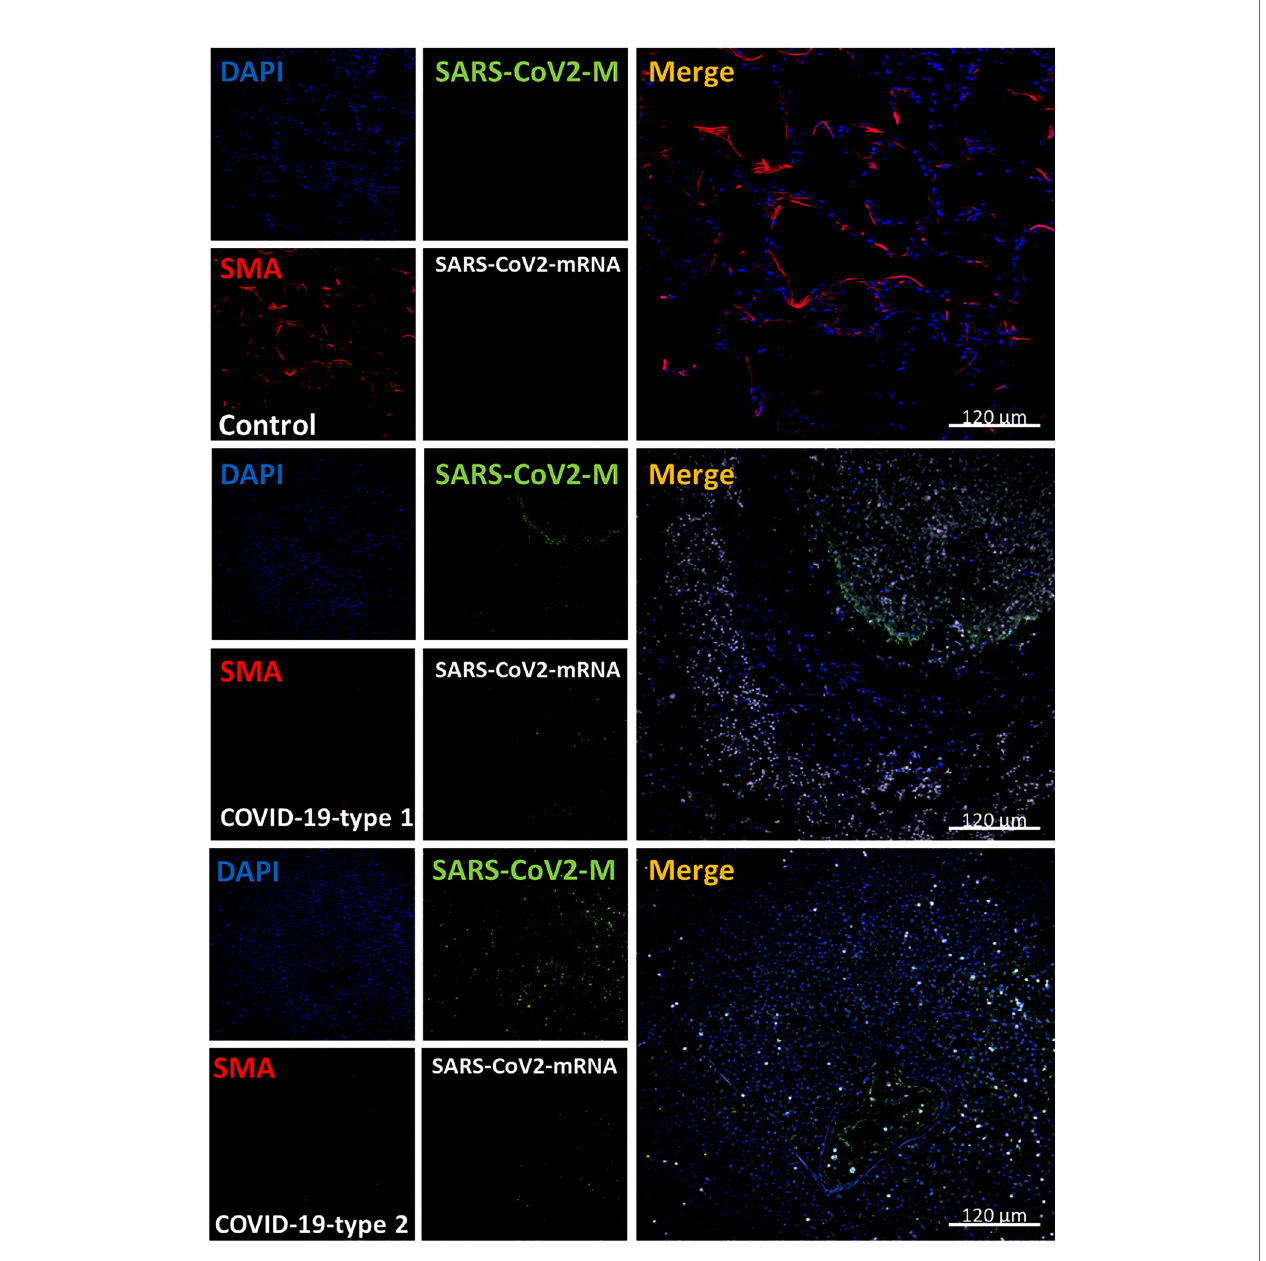
FIGURE 8 | COVID-19 disease induces the total loss of smooth muscle actin cells and lung structure. Staining for nuclei (DAPI, blue staining), SARS-CoV-2 protein M (SARS-CoV-2-M, green staining), smooth muscle actin (SMA, red staining), and SARS-CoV-2-mRNA (White staining) was performed. 3D reconstructions of lung samples collected from uninfected (control) and COVID-19 (Type 1 or 2, enhanced coagulation and immune in fi ltration phenotype). SMA “ decorates ” the alveolar wall in control conditions, and no unspeci fi c viral protein or mRNA staining was found as expected (Control). In contrast, in the enhanced coagulation phenotype (COVID- 19, type I, damage), SMA ’ s signi fi cant total loss was observed (COVID-19-type 1). Again, most viral protein M was concentrated inside blood vessels. In the immune in fi ltrating phenotype, we also observed SMC loss in all samples and areas analyzed. (n = 13-15 different cases analyzed with a least fi ve sections